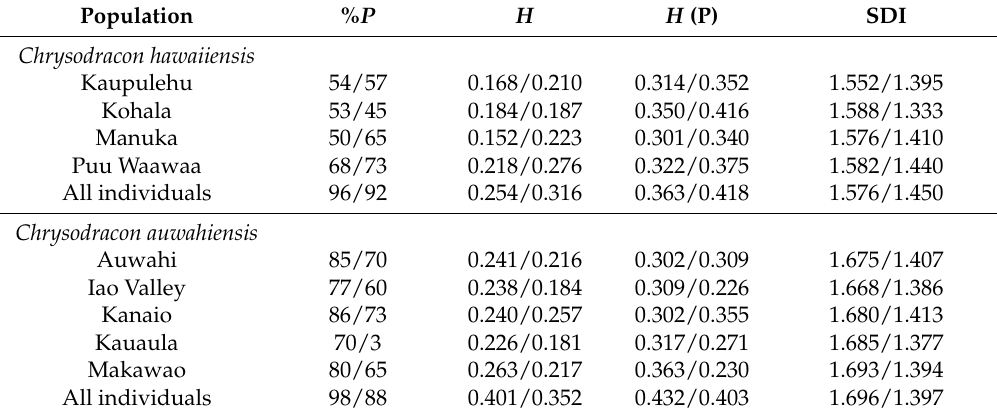
Table 2. Genetic variability among populations of Chrysodracon hawaiiensis ( C. hawaiiensis ) and Chrysodracon auwahiensis ( C. auwahiensis ) based on RAPD and ISSR analyses. Percentage of polymorphic markers (% P ), estimated mean heterozygosity over all markers ( H ), estimated mean heterozygosity over polymorphic markers ( H ( P )), and Shannon’s Diversity Index (SDI). The slash (/) separates values for RAPD and ISSR analyses,